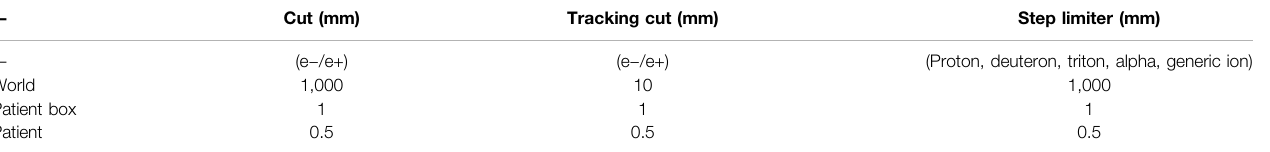
TABLE 2 | GATE-RTion/Geant4 physics settings as con fi gured in the IDEAL implementation used at MedAustron.